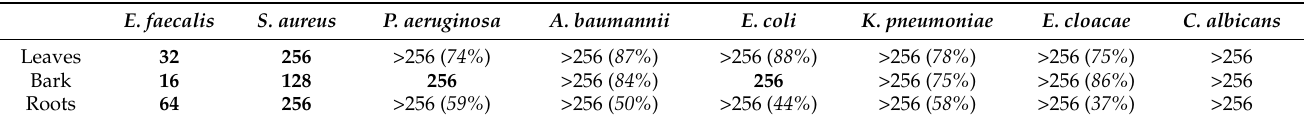
Table 1. Antibacterial and antifungal activities (i.e., MIC in µg/mL) of the raw extracts (MeOH 100%) of Daniellia oliveri parts.